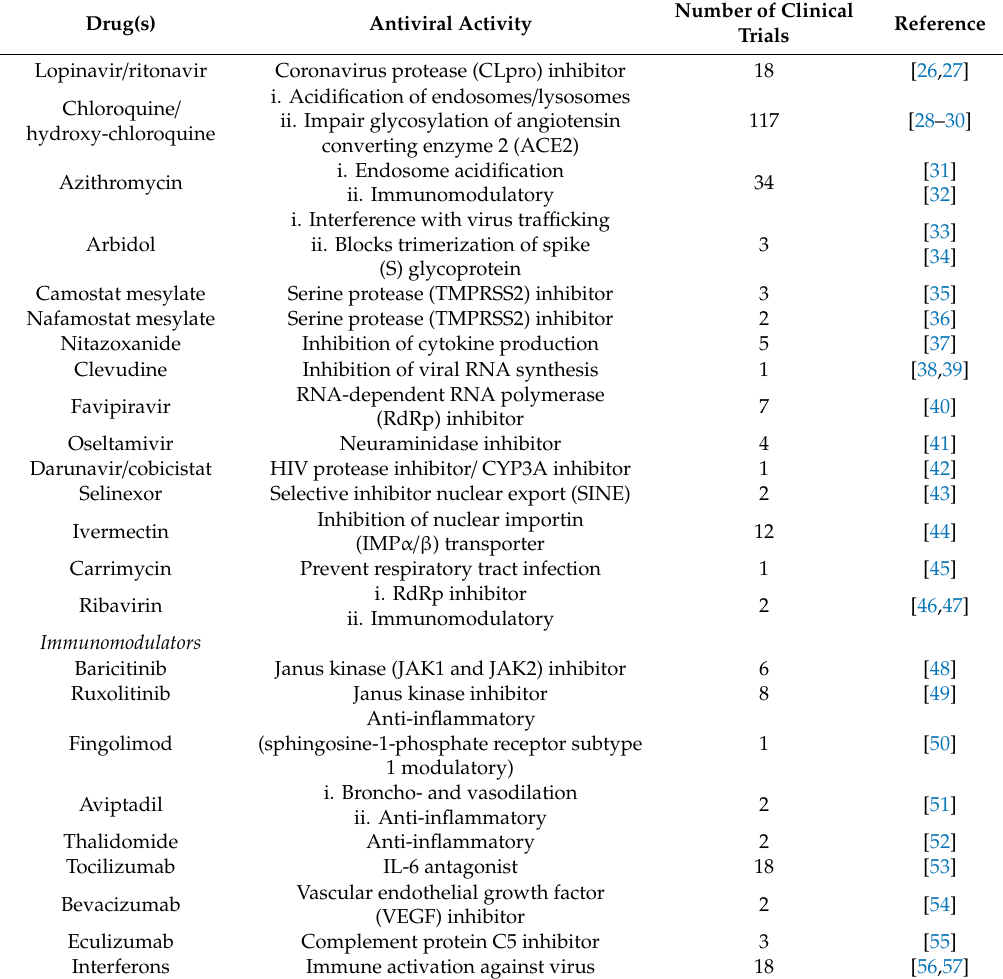
Table 1. Description of repurposed drugs currently in clinical trials for